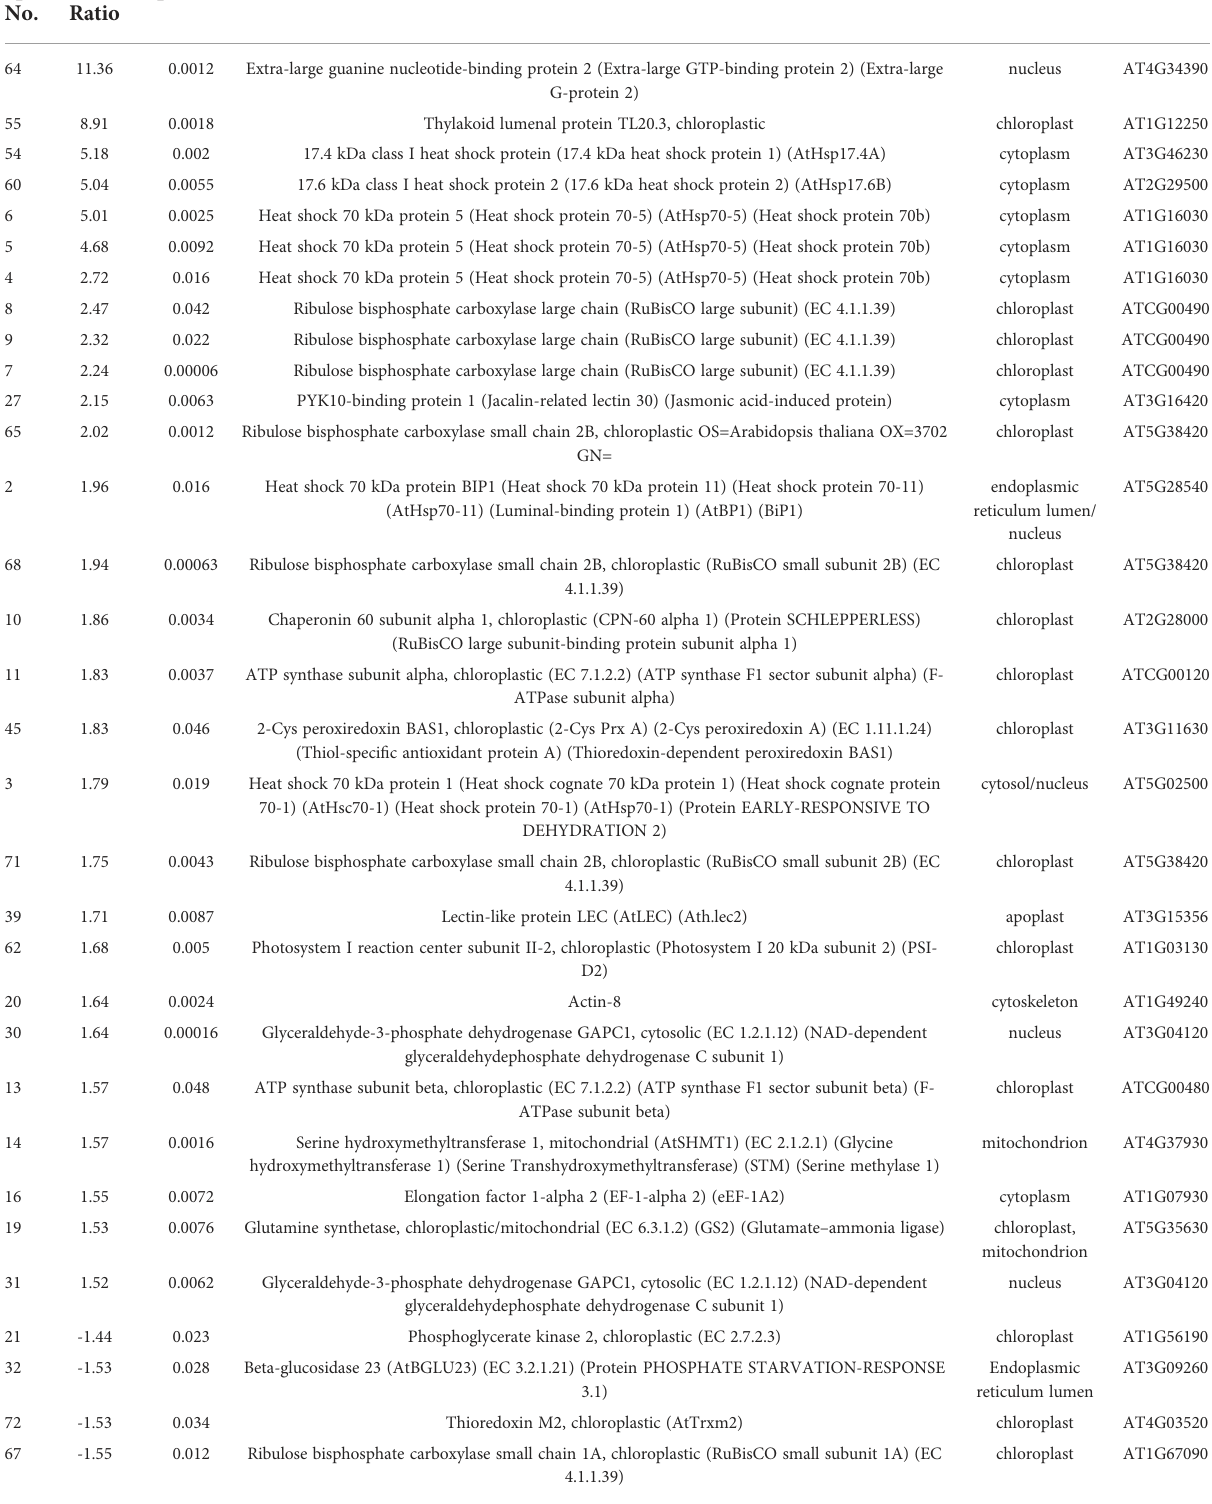
TABLE 1 Proteins affected by IC 50 SPC treatments. Spot